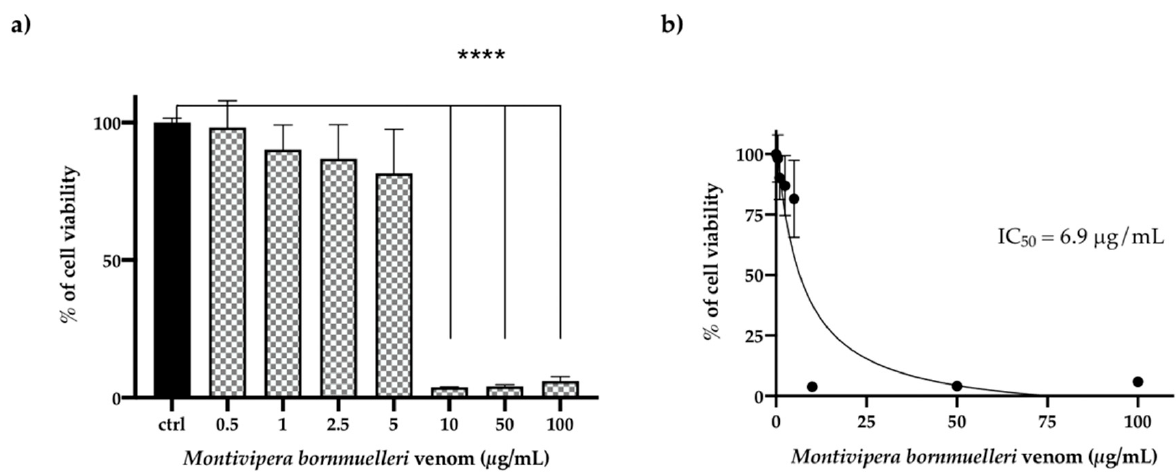
Figure 3. Cell viability of HCT116 colon cancer cells was measured by MTT assay after treatment with increased con- centrations of M. bornmuelleri venom. ( a ) Results are expressed as mean ± SD of three independent experiments ( n = 3). One-way ANOVA test: ns (no significant), **** p < 0.0001 when compared with the control. At 10, 50 and 100 µ g/mL, the M. bornmuelleri venom showed a high cytotoxic activity against HCT116 cancers cells. ( b ) Curves for MTT assay showing IC 50 values and the % of cell viability in function of concentrations M. bornmuelleri venom.